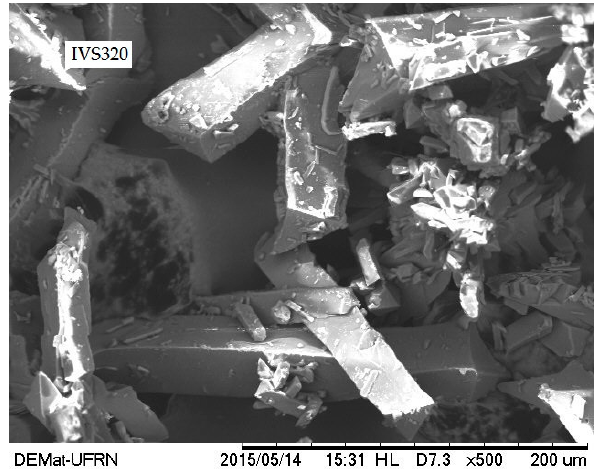
Figure 4. Scanning electron microscopy (SEM) micrograph of IVS320 at magnification of 500×.